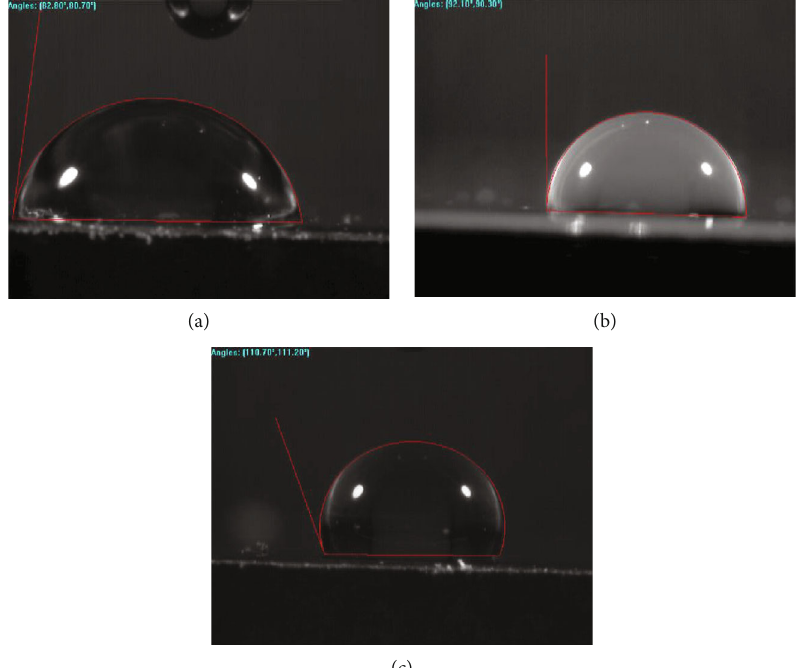
Figure 2: Images of water contact angles: (a) neat polyimide, (b) neat polyurea, and (c) poly(urea-imide) (50% polyurea). Courtesy of Feng and Iroh